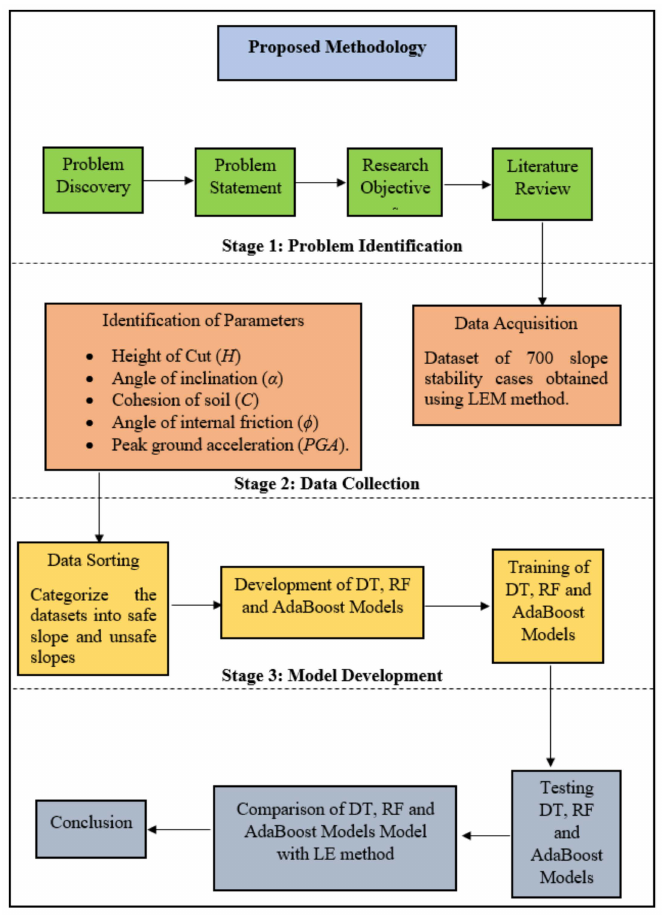
Figure 2. Procedure flowchart for FOS